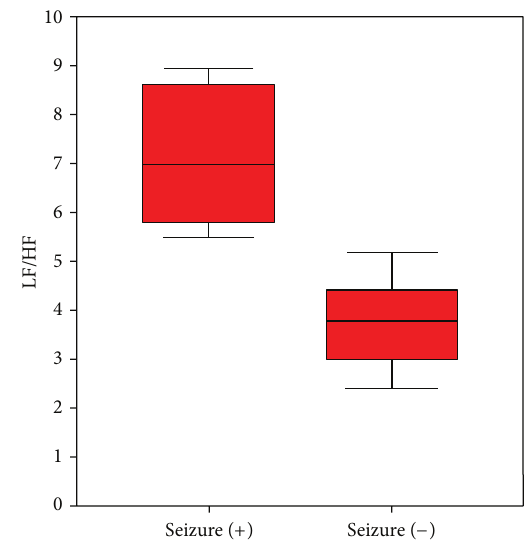
Figure 2: Comparison of the LF/HF ratio during the first 5 minutes of the HRV analysis according to the presence of seizures in patients with TCA